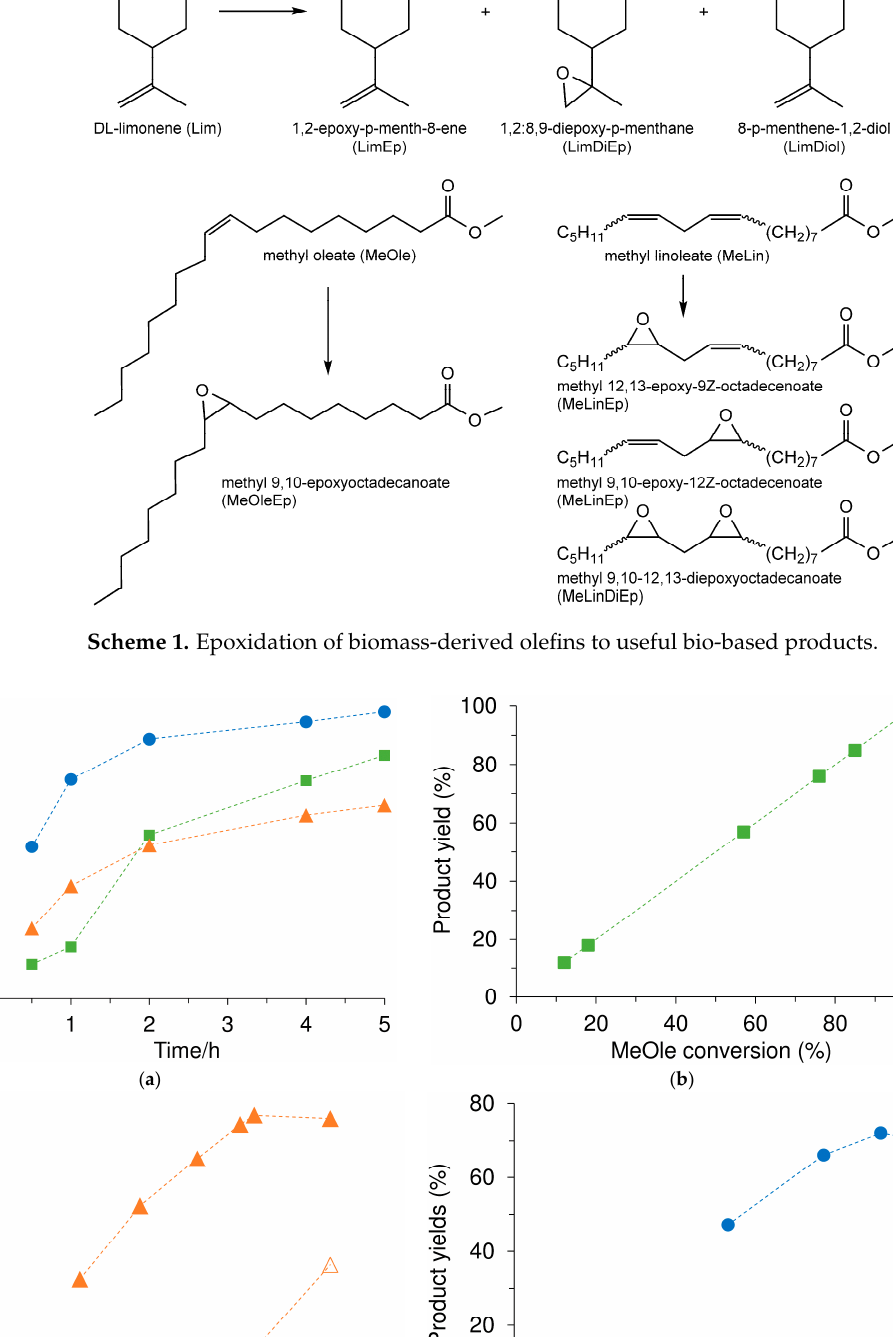
Figure 13. ( a ) Kinetic profiles of the reactions of MeOle ( ■ ), MeLin ( ▲ ), and Lim ( ● ) in the presence of 2 . Respective product yields: ( b ) MeOle reaction—MeOleEp ( ■ ); ( c ) MeLin reaction—MeLinEp ( ▲ ), MeLinDiEp ( △ ), and cyclization products ( ◆ ); ( d ) Lim reaction—LimEp ( ● ), LimDiEp ( ○ ), and LimDiol ( ■ ). ); Lim is a cyclic terpenic diene found in citrus oils. The corresponding epoxide products, namely 1,2 ‐ epoxy ‐ p ‐ menth ‐ 8 ‐ ene (LimEp) and 1,2:8,9 ‐ diepoxy ‐ p ‐ menthane